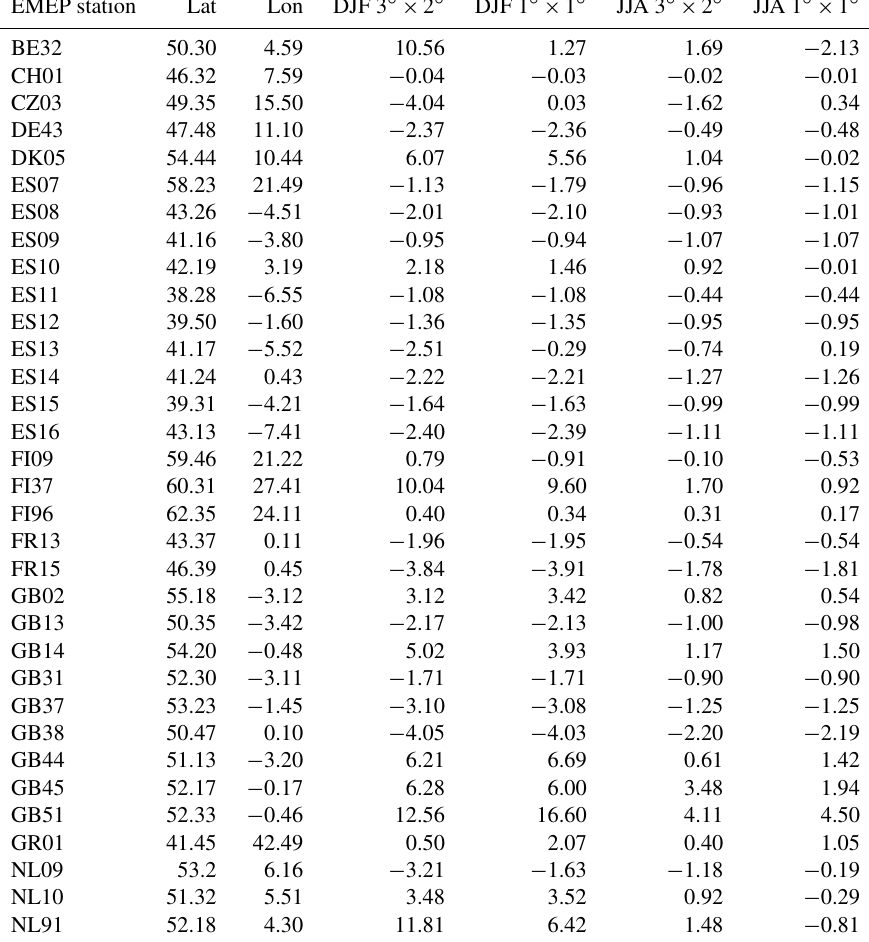
Table 7. As for Table 5 except for NO 2